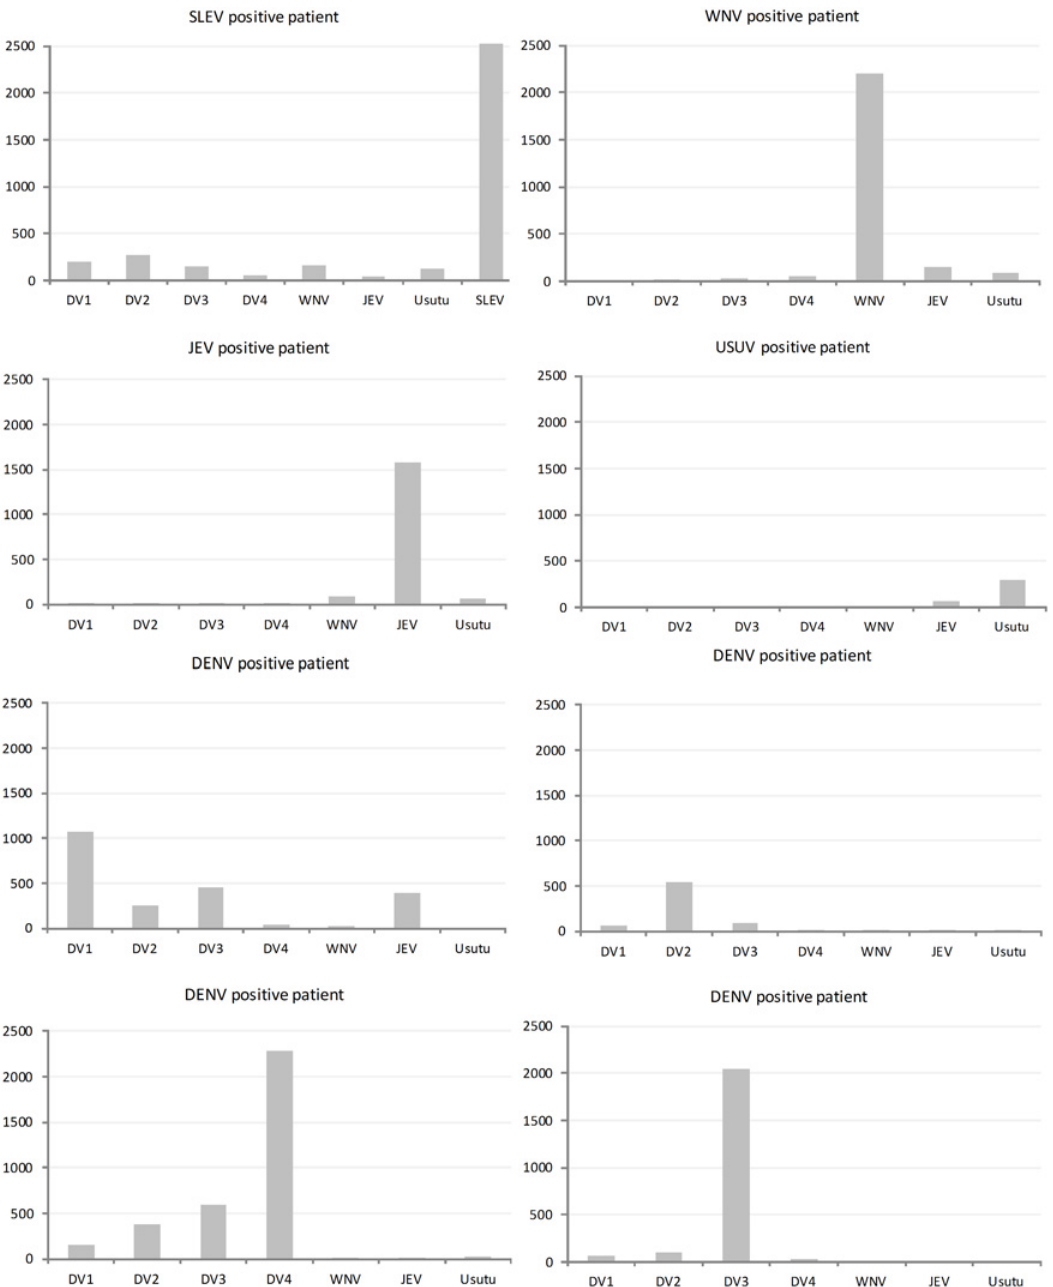
Fig 4. Representative examples of IgG antibody profiles of individual patients infected with JEV and DENV serocomplex viruses. Antibody profiles are presented as titers (y-axis) for each NS1-protein (x-axis).